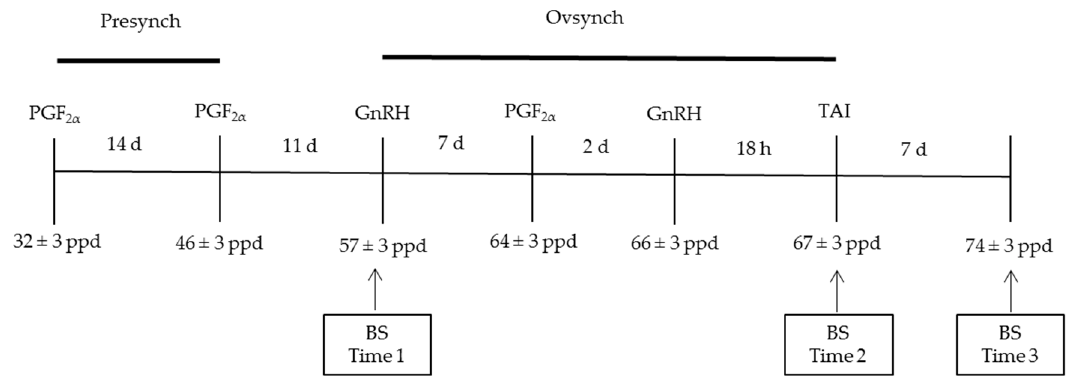
Figure 1. Diagram of blood samples and reproductive management. TAI = fixed-time artificial insemination, ppd = postpartum day, and BS = blood sample collection.